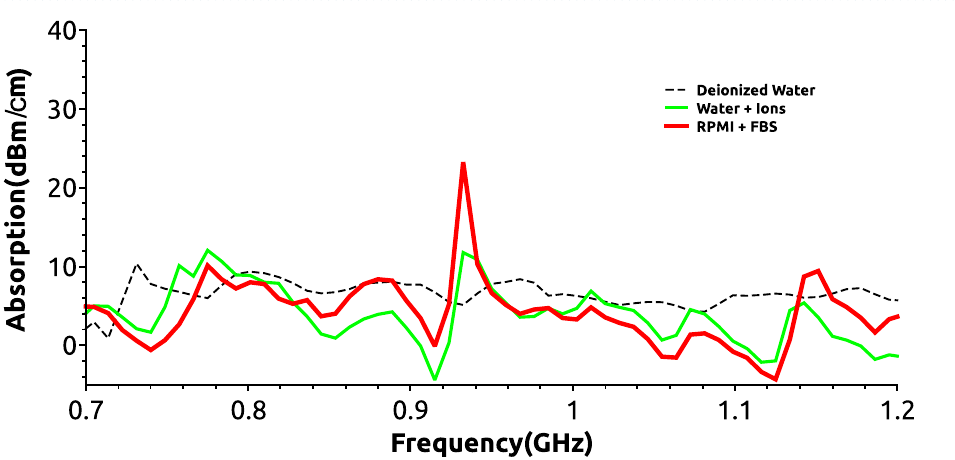
Figure 2. Absorption spectra measurements of filtered deionized water (dashed thin black line), tap water (green thick line Water + Ions) and RPMI cell culture medium with 10% fetal calf serum (FBS)(red thick line RPMI + FBS) All measurements were done using a Keysight-AGILENT-HP N9935A spectrum analyzer as described in “Methods”